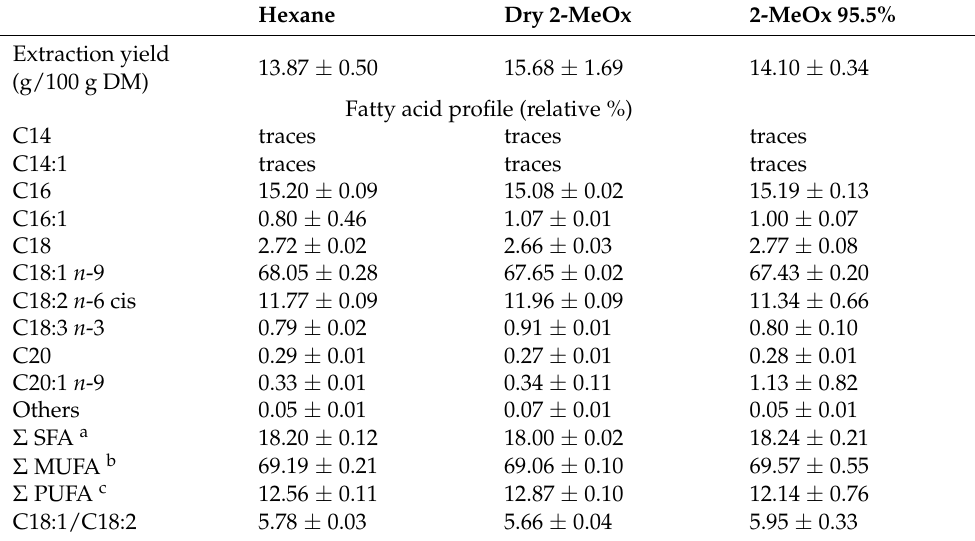
Table 3. Extraction yield and fatty acid profile of OP extracts obtained with hexane, dry 2-MeOx and 2-MeOx 95.5%.